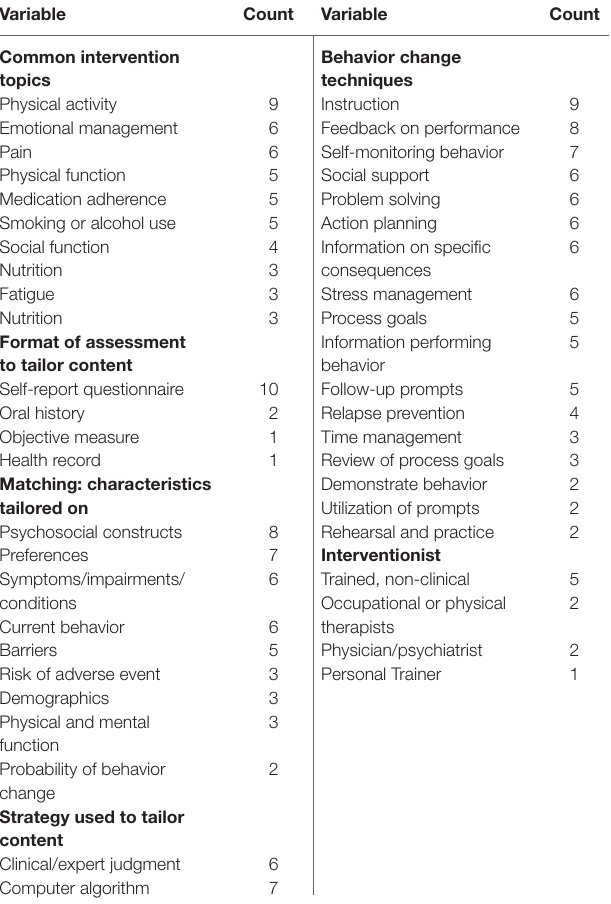
TABLe 3 | Overall characteristics of the 13 interventions. variable Count variable